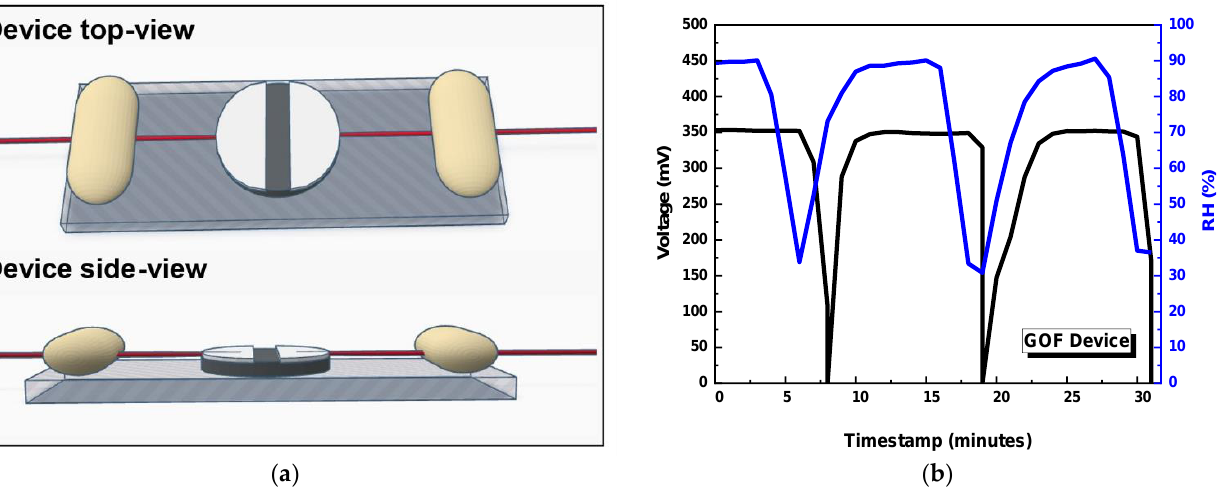
Figure 6. ( a ) Schematic representation of MEG device constructed using GOF as the moisture absorbing material and large surface area contacts in the horizontal configuration; ( b ) Moisture- induced voltage (V o ) generated by GOF device after applying high bias at 90% humidity for 30 min.